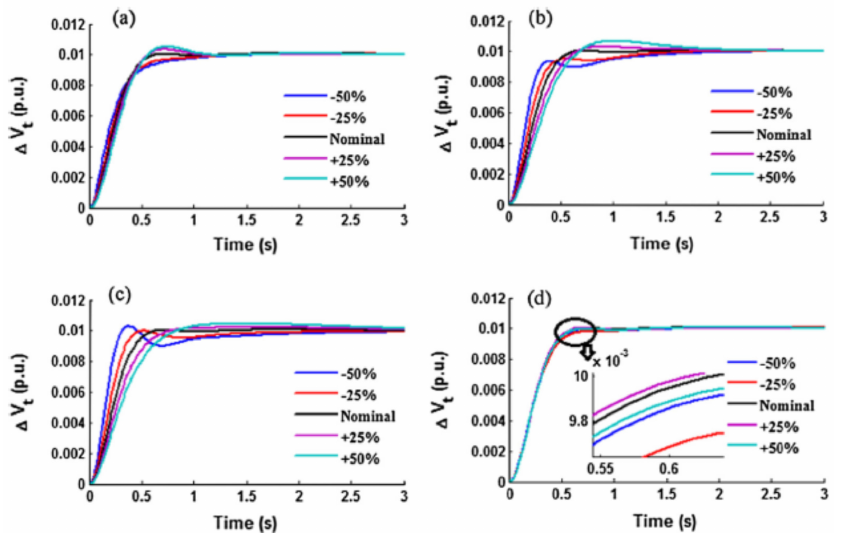
Figure 15. Step response for the per-unit output voltage variation under different variation of time constants ( a ) τ A ( b ) τ E ( c ) τ G ( d ) τ S “Adapted with permission from Ref. [18]”.